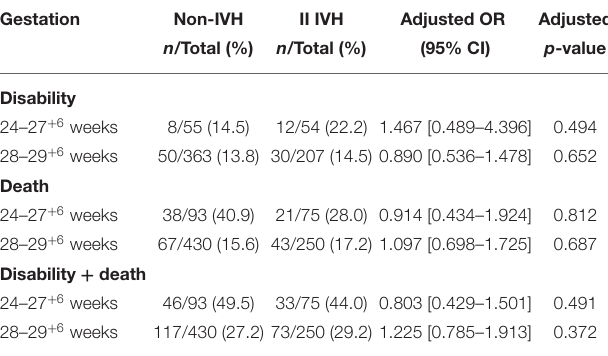
TABLE 3 | Subgroup analysis the impact of I-II IVH on outcomes at 18–24 months of corrected